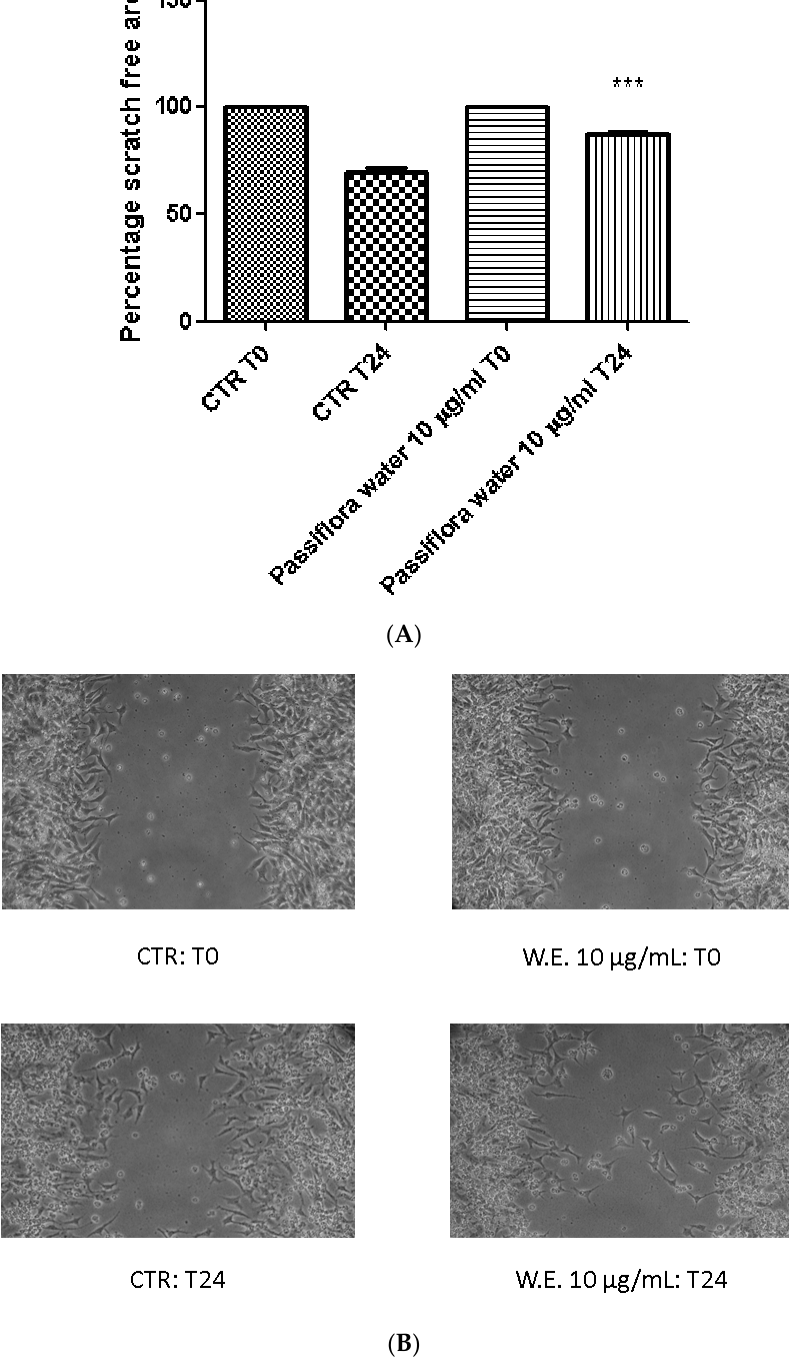
Figure 4. Effects of subtoxic concentration (10 μ g/mL) of P. foetida water extract on spontaneous hypothalamic HypoE22 cell migration. Quantification of free cell area ( A ) and representative images ( B ) of wound healing test recorded at different time (T) points: 0 and 24 h following stimulation. ANOVA, p < 0.001; *** p < 0.001 vs. CTR T24. Additionally, none of the two extracts were able to prevent the hydrogen peroxide-induced decrease of extracellular 5-HT level (Figure 5).